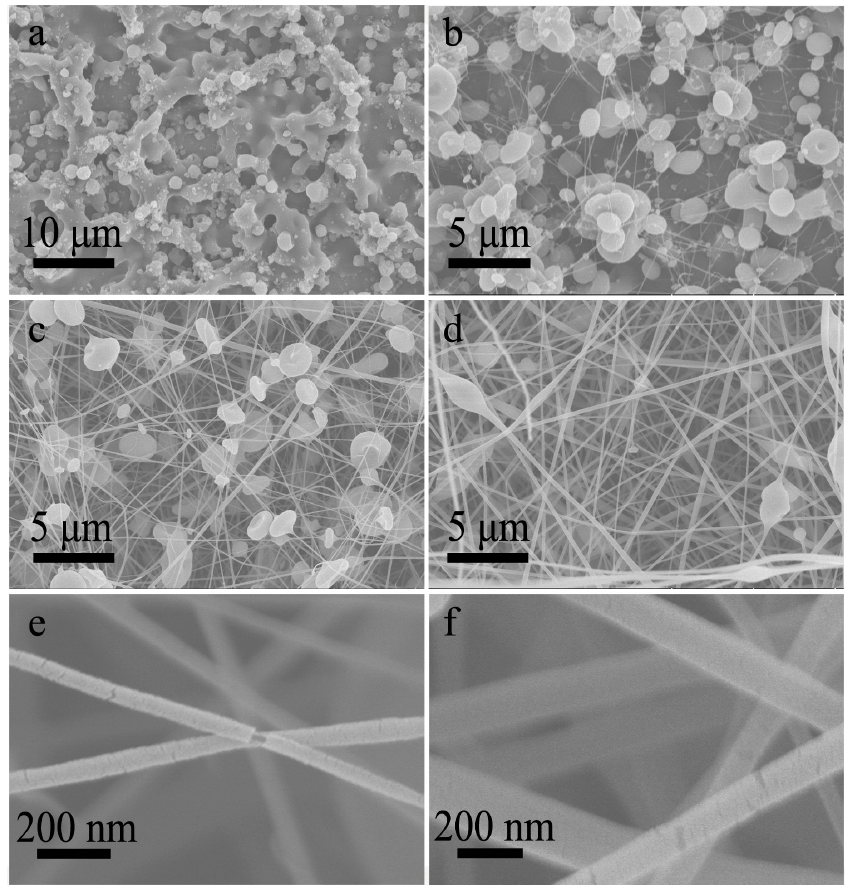
Figure 7. ( a – d ) SEM images of nanofibers prepared by co-electrospinning of core CA-A solution and shell CA-D solution under core-to-shell flow ratio of ( a ) 1:3, ( b ) 1:1.5, ( c ) 1.5:1, ( d ) 3:1, respectively. ( e , f ) The amplified SEM images corresponding to ( c , d ), showing the core-shell structure.